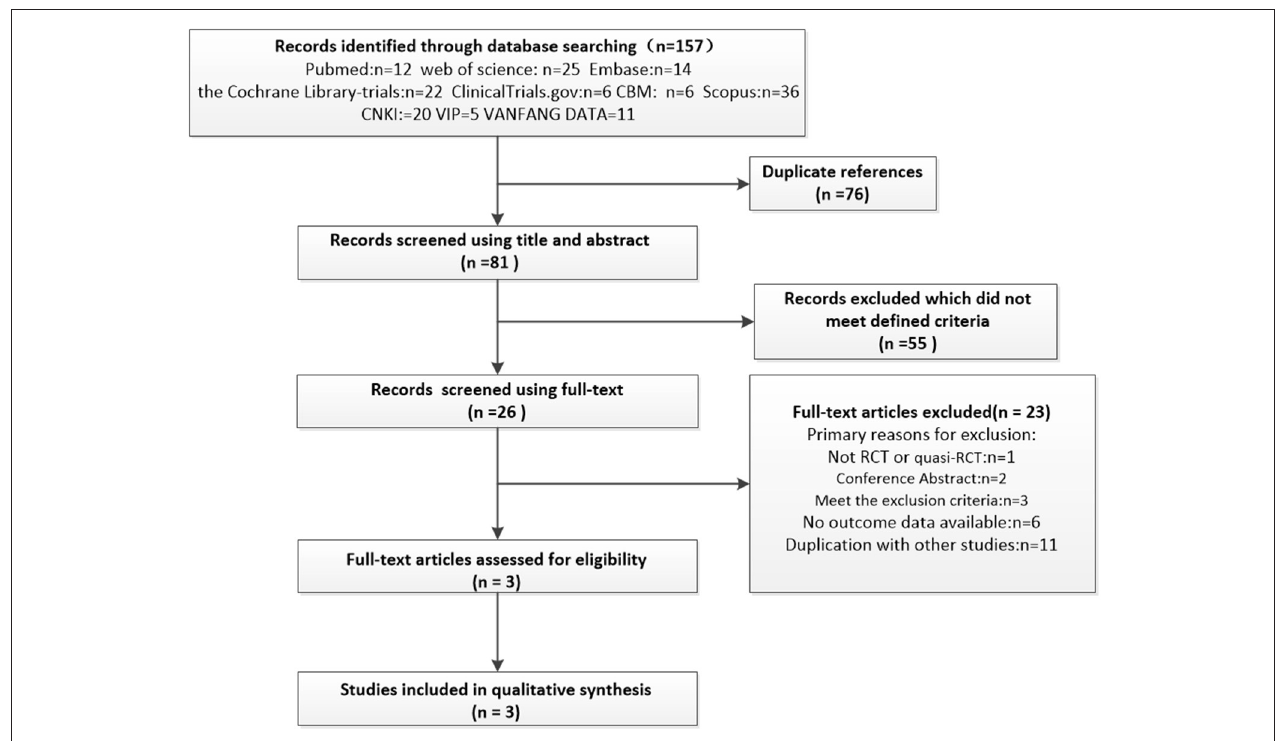
FIGURE 2 | The flowchart of the selected